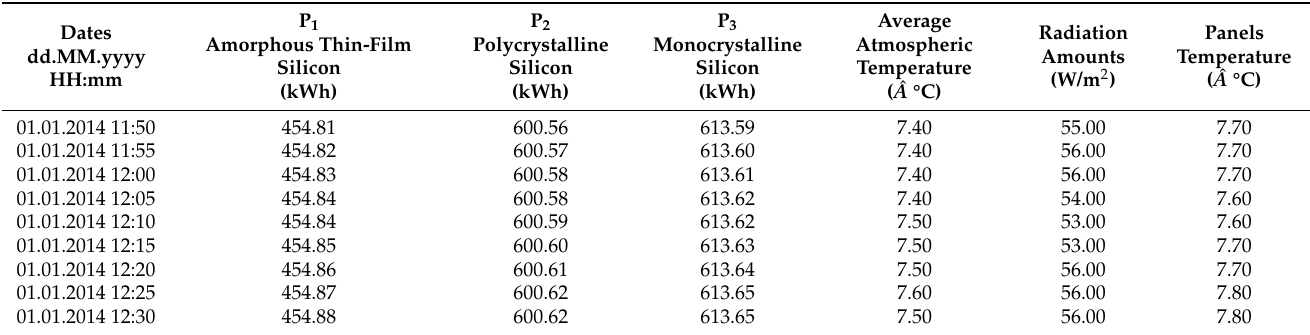
Table 2. Data from PV panels recorded every five minutes in DUBIT.